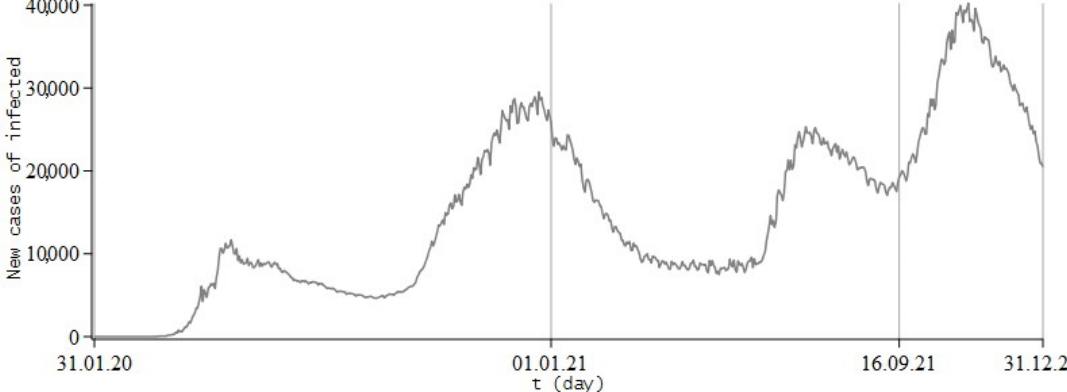
Figure 12. Experimental data: for new cases of COVID-19 infection in the Russian Federation, from